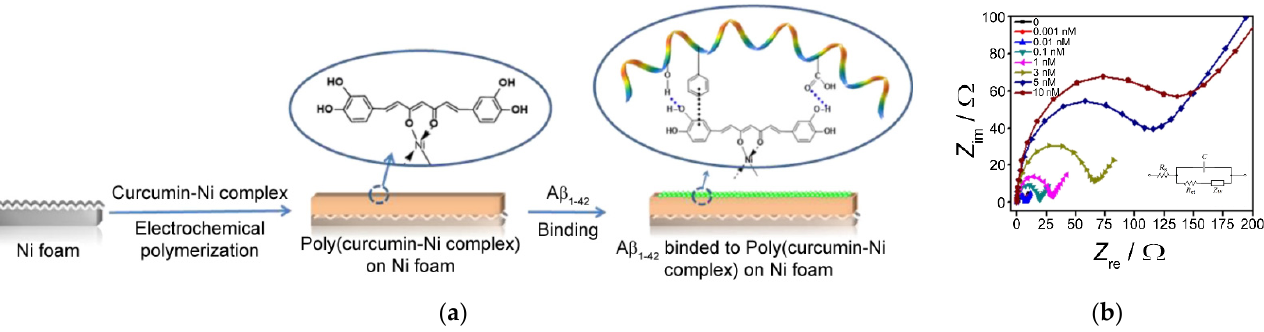
Figure 5. ( a ) Schematic representation of the synthesis of poly(curcumin-Ni complex) and its binding to amyloid β oligomer (A β 1–42 ); ( b ) Nyquist plots of poly(curcumin-Ni complex) sensor after incubation in various concentrations of amyloid β oligomer solution. Reprinted from [59] with permission from Elsevier.